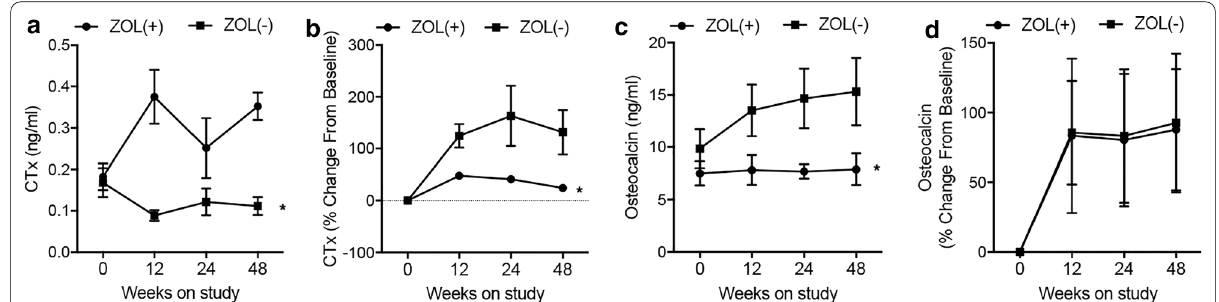
Fig. 1 CTx and Osteocalcin expression was suppressed by ZOL treatment in HIV patients receiving tenofovir treatment. a Model‑based mean longitudinal changes of CTx concentration in 48 weeks in ZOL‑treated HIV patients receiving tenofovir treatment. b Model‑based mean CTx percentage change from baseline in 48 weeks in ZOL‑treated HIV patients receiving tenofovir treatment. c Model‑based mean longitudinal changes of Osteocalcin concentration in 48 weeks in ZOL‑treated HIV patients receiving tenofovir treatment. d Model‑based mean Osteocalcin percentage change from baseline in 48 weeks in ZOL‑treated HIV patients receiving tenofovir